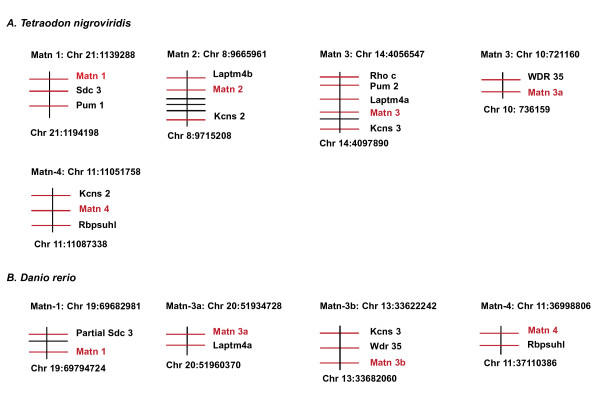
Genomic contexts of matrilin genes in T. nigroviridis and D. rerio. The genomic contexts of matrilin gene family members from (A), T. nigroviridis and (B), D. rerio, were analysed for conservation of neighboring genes with human, mouse and chicken, as shown in Fig. 3, and with each other. Partial synteny was identified. Each diagram represents the order of genes along a portion of the indicated chromosomes. Each horizontal line represents a gene: red lines represent genes that are syntenic and black lines represent non-conserved intervening genes. The numbers indicate the exact location in nucleotides of each region on its respective chromosome in each species. HUGO gene names are given, and the matrilin genes are indicated in red.